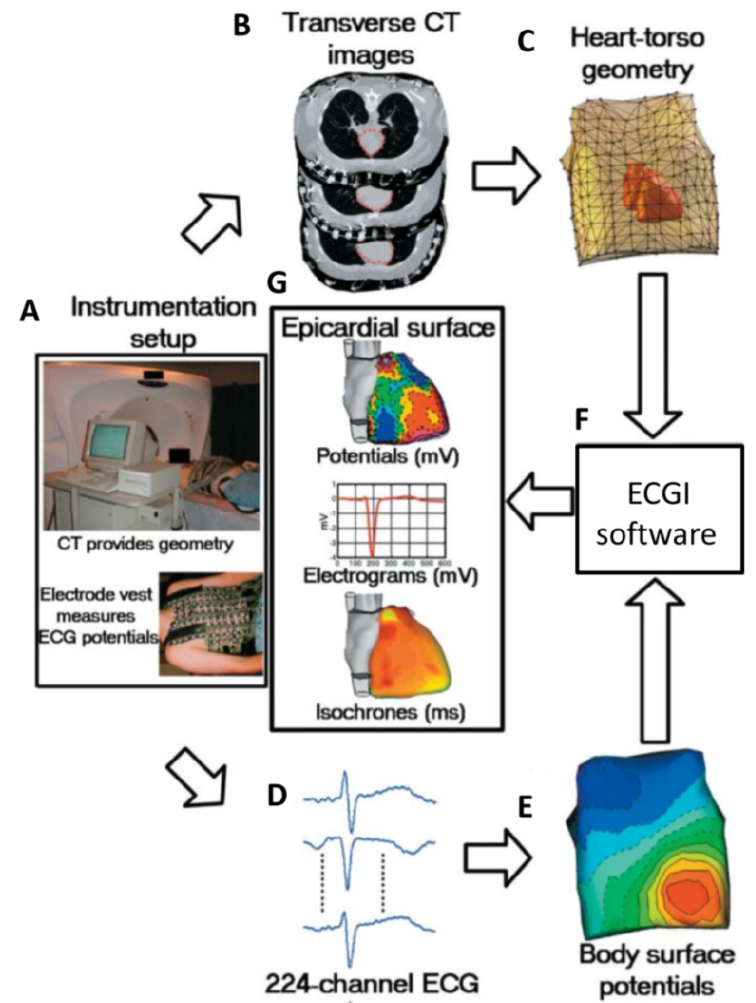
Figure 4. Block diagram of ECGI. ( A ) Photographs of instrumentation setup. ( B ) CT transverse slices showing heart contours (red) and body-surface electrodes (shiny dots). ( C ) Meshed heart-torso geometry. ( D ) Sample ECG signals obtained from the mapping system. ( E ) Spatial representation of body surface potential mapping. ( F ) ECGI software package. ( G ) Examples of non-invasive ECGI images, including epicardial potentials, electrograms, and isochrones. Figure reproduced with permission from Ramanathan, C. et al. Non-invasive electrocardiographic imaging for cardiac electrophysiology and arrhythmia. Nat. Med. 2004 , 10 , 422–428, doi:10.1038/nm1011 (accessed on 20 May 2021).